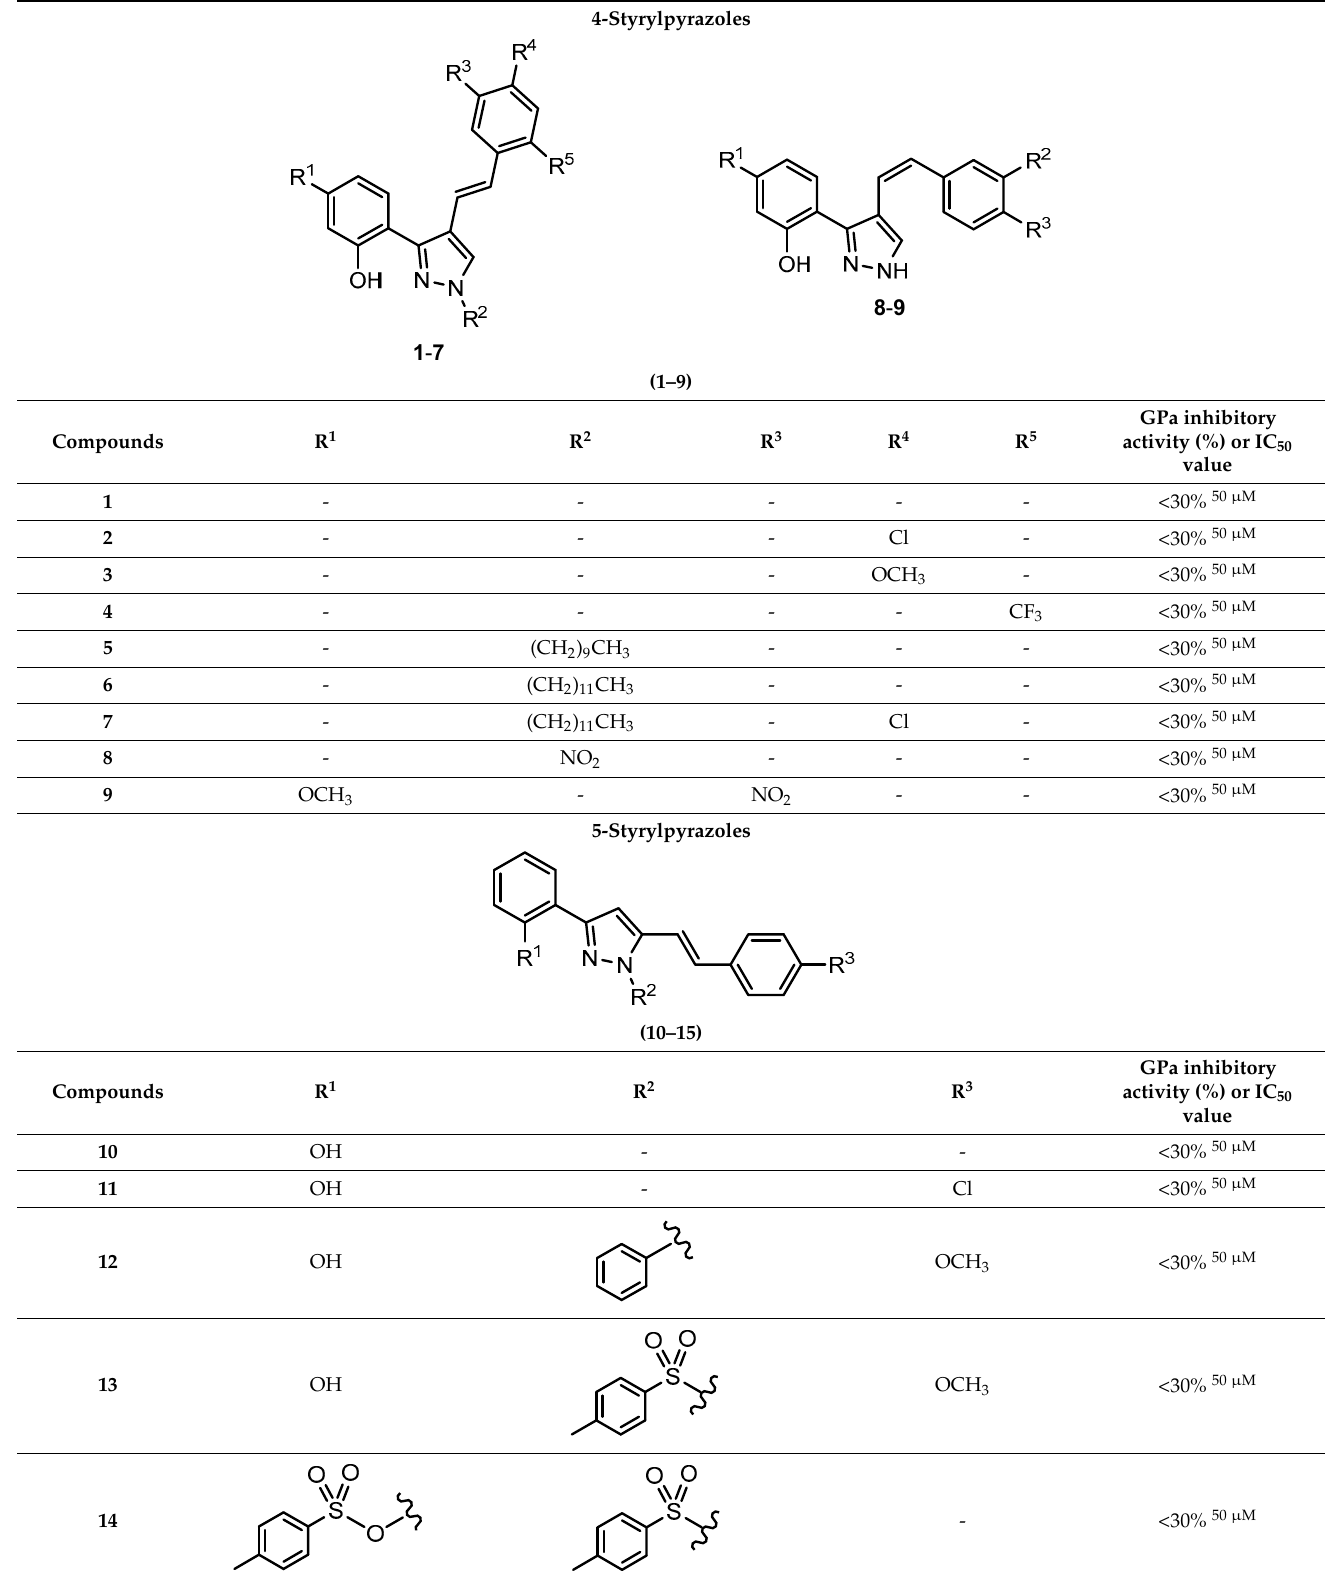
Table 1. Chemical structures and in vitro inhibitory activities of styrylpyrazoles, namely, 4- and 5- styrylpyrazoles, as well as the chromone derivatives 2-styrylchromones, the 2-styrylchromone-related